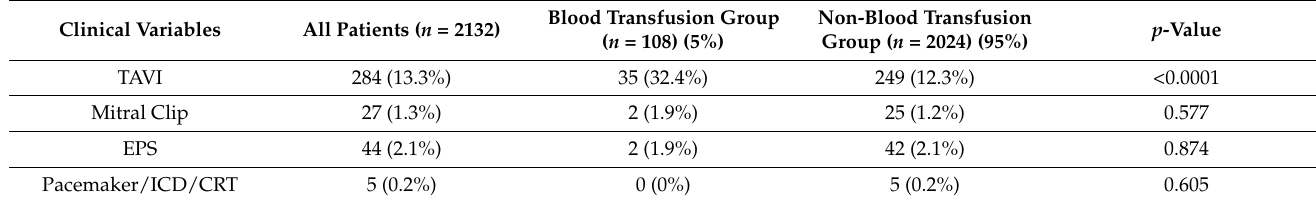
Table 3. Blood transfusion rate according to cardiac